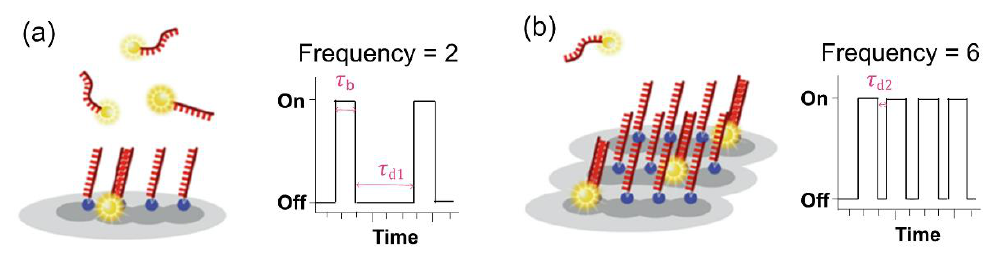
Figure 11. Principle of quantitative PAINT (qPAINT). ( a ) Intensity versus fluorescence on and off times ( τ b and τ d , respectively), characterized by the transient binding of fluorescence-labeled imager strands and docking strands. ( b ) High frequency of the imager strand binding with docking sites, with time trace versus intensity. The images were reproduced with permission from Lin et al., published by Academic Press Inc. Elsevier Science, 2020 [51].